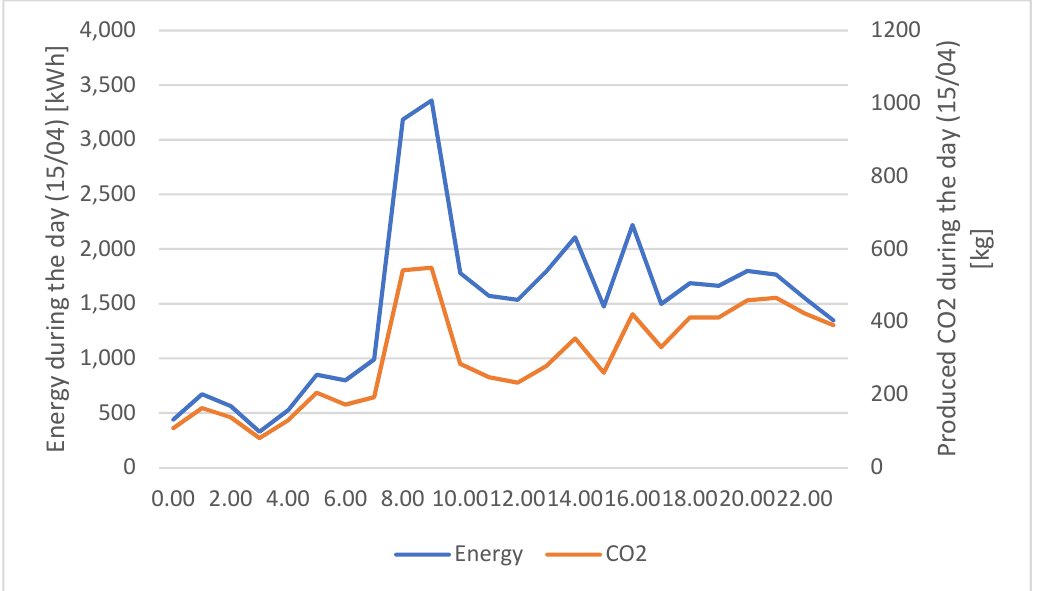
Figure 5. Aggregate CO 2 graph obtained from average users.